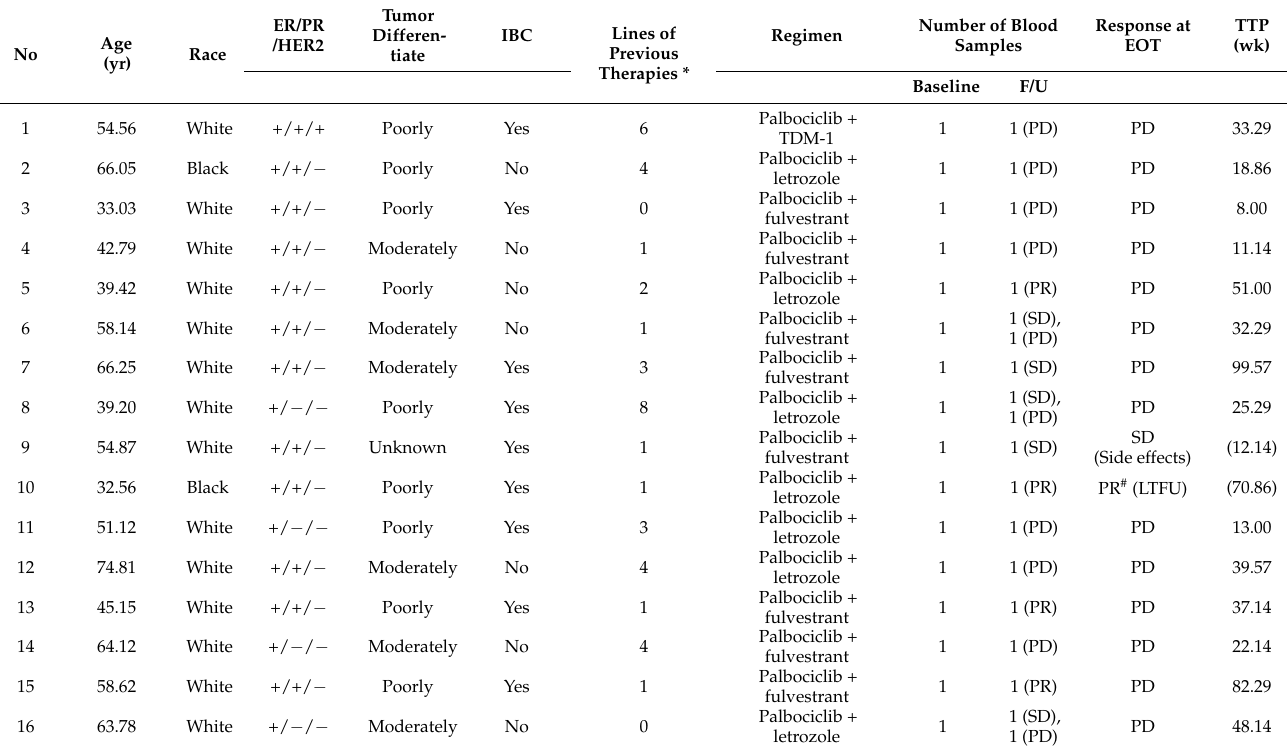
Table 1. Clinical characteristics of 16 MBC patients receiving